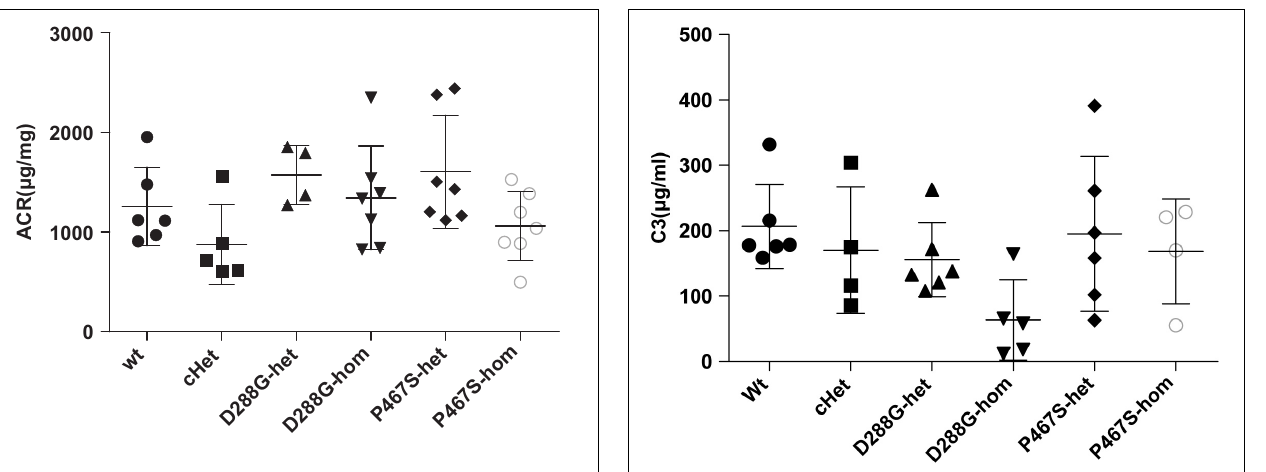
Frontiers in Physiology |